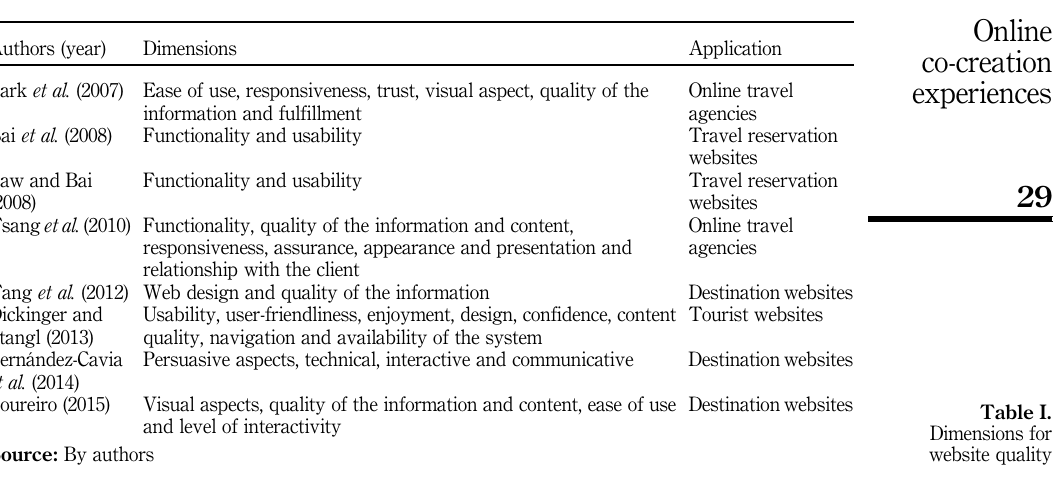
Table I. Dimensions